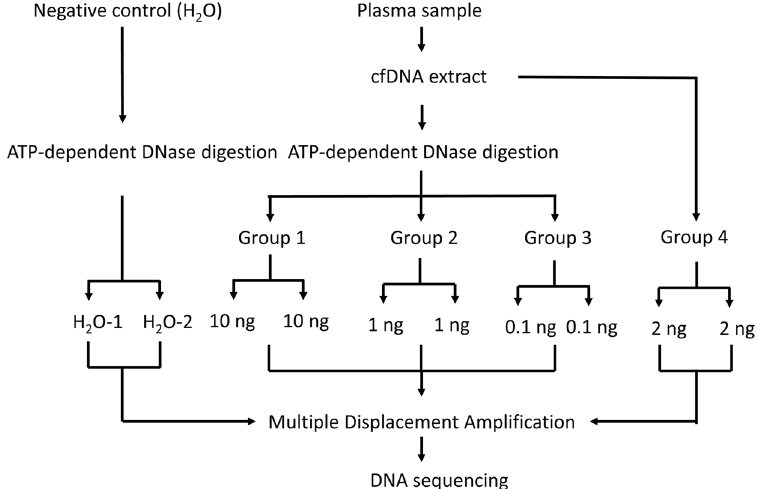
Figure 1. Study design to characterize eccDNAs in human plasma. cfDNAs from three plasma samples were divided into four groups. Groups 1, 2 and 3 were subjected to the ATP-dependent DNase digestion and MDA procedures while Group 4 went directly to the MDA procedure. Each group has a technical replicate. Water was used as a negative control. A total of 26 libraries were prepared for DNA sequencing. Another four libraries from one additional plasma cfDNA sample were sequenced as a validation.